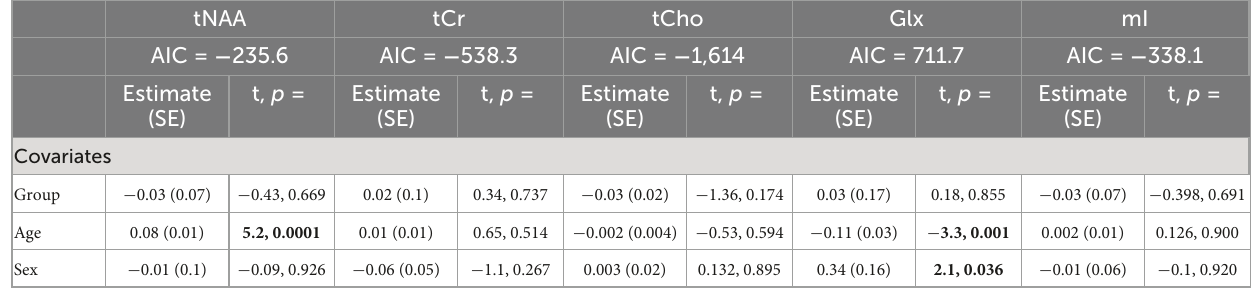
TABLE 9 Summary of the independent univariate general linear model (GLM) models for each metabolite to investigate group differences (concussion vs. OI) in tNAA, tCr, tCho, Glx, and